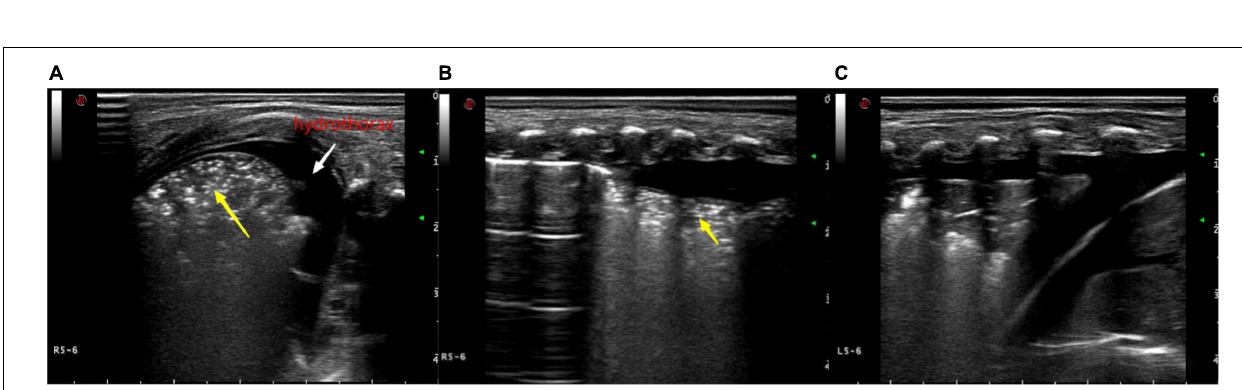
FIGURE 3 | Ultrasonic manifestations of neonatal lung consolidation. Pulmonary ultrasound shows an irregular consolidation area with a hyperechoic air bronchogram sign. It shows that dot or linear hyperechoic artifacts vary with breathing in the lung consolidation tissue and pleural lines. Normal lung tissue can be observed at its location. (A) Longitudinal image of intercostals. (B) Transverse image of intercostals. (C) X-ray showing multiple patchy fuzzy shadows in both lungs.